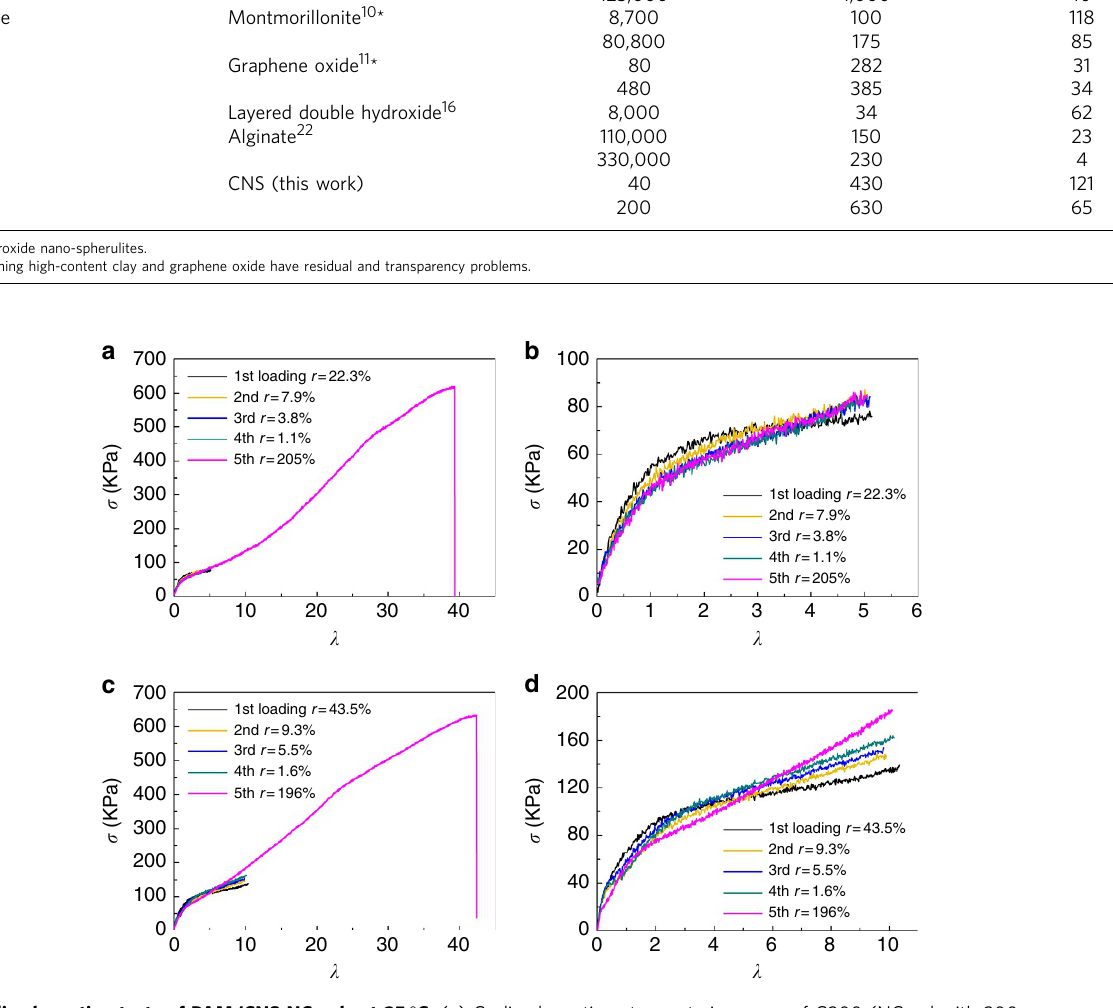
Table 1 | Elongation stress and stretch ratio at rupture of synthetic elastic hydrogels with different crosslinkers. Matrix Particle Content (p.p.m.) Stress (KPa) Stretch ratio Poly( N -isopropylacrylamide)